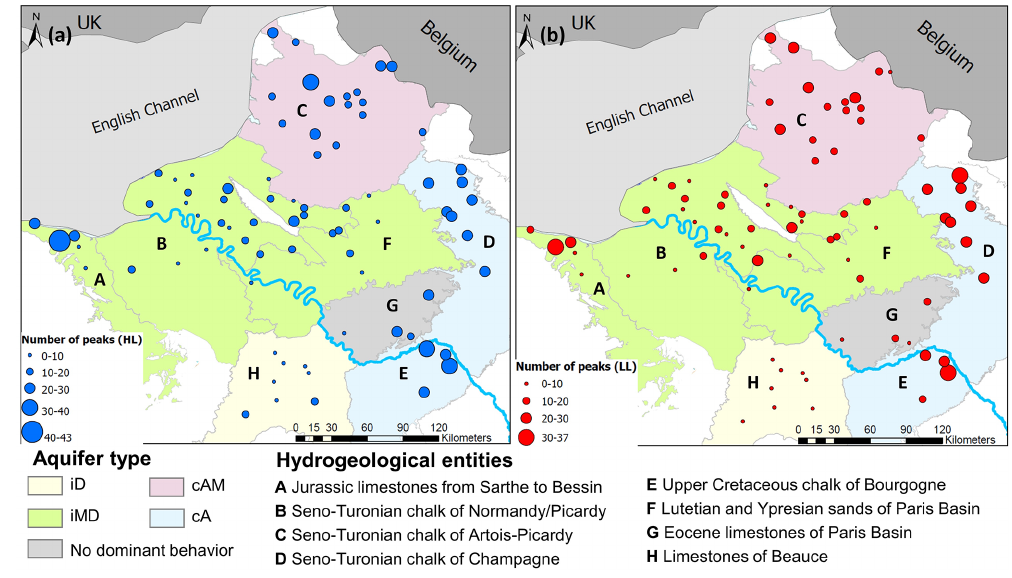
Figure 7. Number of HL peaks above percentile 0.8 (a) and LL peaks below percentile 0.2 (b) over the 1976–2019